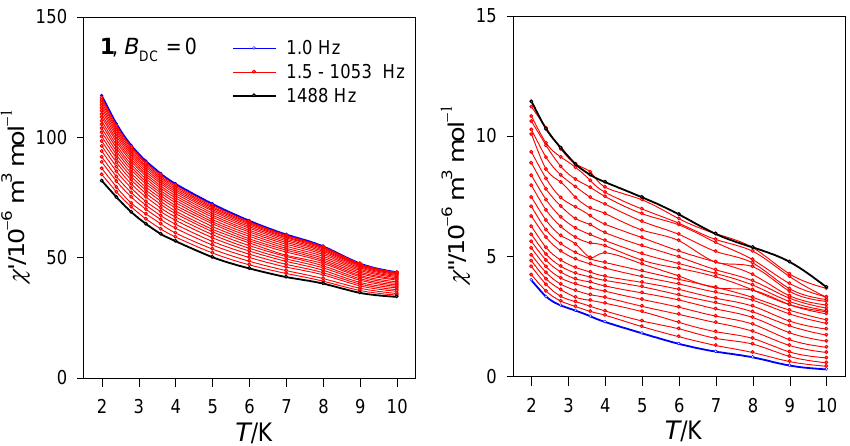
Figure 6. Temperature dependence of the AC susceptibility for 1 .